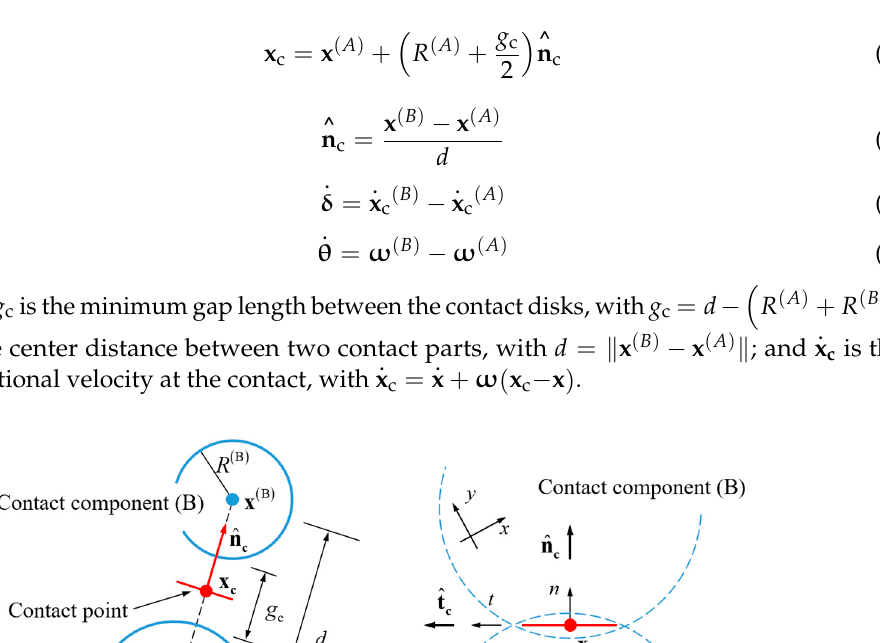
Figure 2. Diagram for the contact detected in a 2D particle flow model.